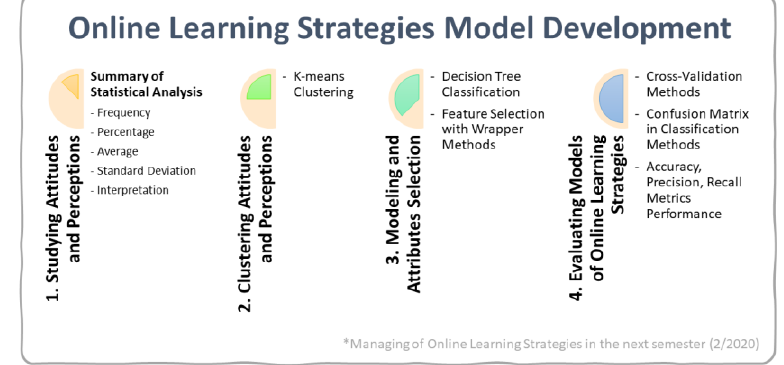
Fig. 1. The Conceptual Framework